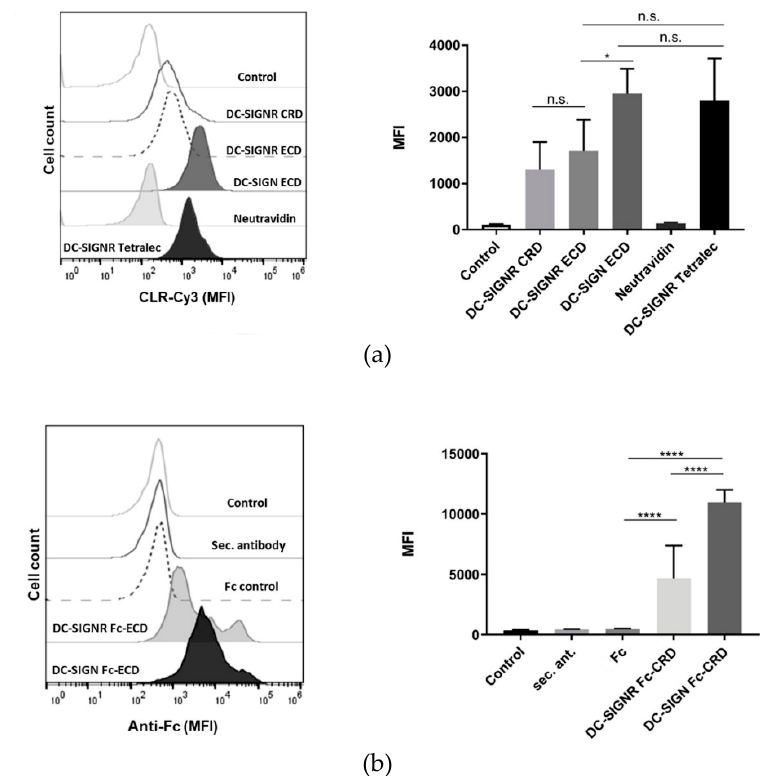
Figure 7. Heat-killed Candida albicans recognition by DC-SIGNR. ( a , left) Representative experiment of the histograms obtained for heat-killed C. albicans (HKCA) binding by the di ff erent DC-SIGNR-Cy3 constructs. DC-SIGN ECD was used as a positive control. ( a , right) Mean fluorescent intensity (MFI) of DC-SIGNR-Cy3 constructs binding to HKCA. Data depicted are the average of at least three independent experiments. ( b , left) Representative experiment of Fc-CRD fusion proteins recognition of HKCA. Fc and the secondary antibody were used as negative controls, while DC-SIGN Fc-CRD is the positive control. ( b , right) Average of the MFI values obtained. Data showed are the average of at least five independent experiments. Statistical analysis of the MFI results was performed using the unpaired Student’s t test, where p-values of < 0.05 were considered to be significant (n.s. = not significant, * p ≤ 0.05, **** p ≤